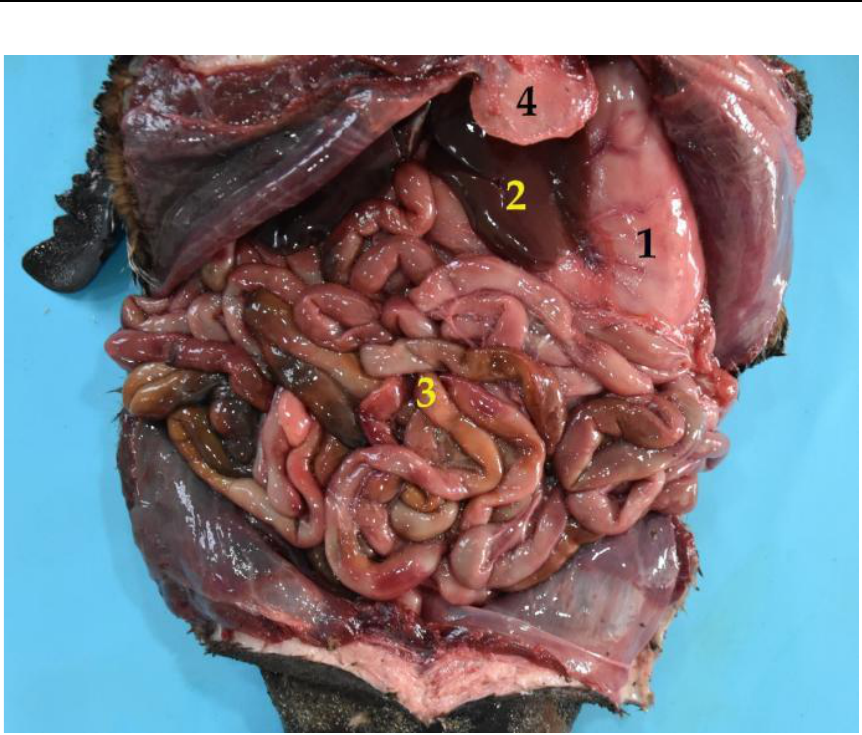
Figure 10. General view of the abdominal cavity (body in dorsal recumbency). ( 1 ) Stomach; ( 2 ) liver; ( 3 ) jejunum; ( 4 ) xiphoid cartilage.